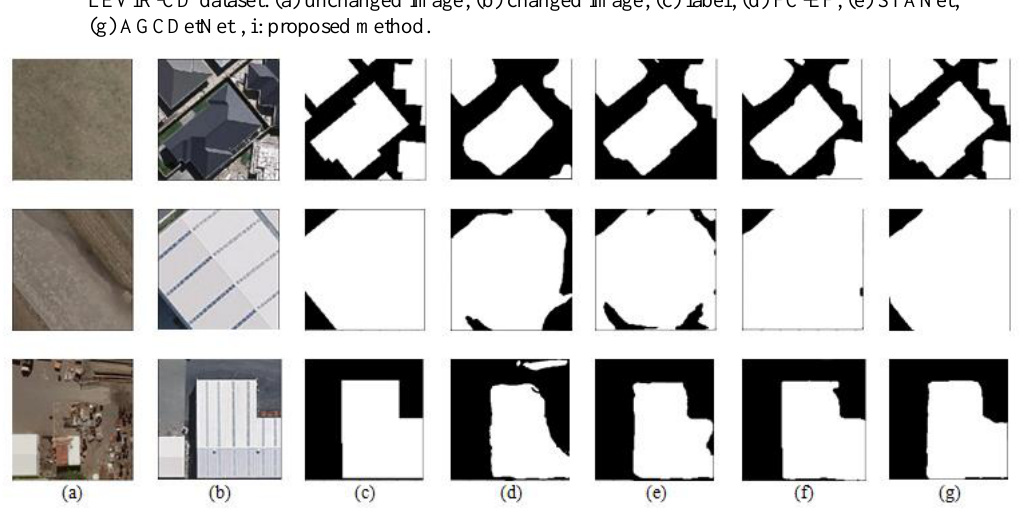
Figure 4. Visual comparison between state-of-the-art methods and proposed method on the BCDD dataset. (a) unchanged image, (b) changed image, (c) label, (d) FC-EF, (e) STANet, (g) AGCDetNet , i: proposed